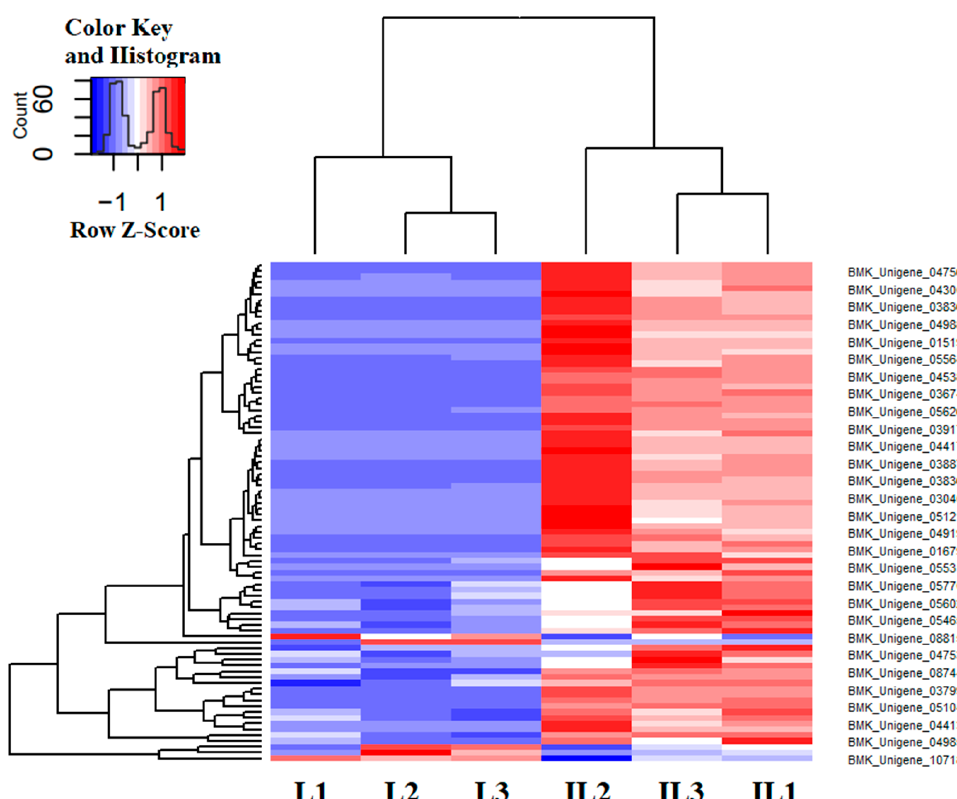
Figure 5. The heatmap of the cluster diagram of differentially expressed immune-related gene expression patterns in IL vs. L. Each column represents one sample. Rows represent different genes. The expression level of genes (FPKM) was normalized by log2 and presented as different colors based on scale bar. L represents the pre-infected larva of H. xiaojinensis. IL represents the one-year post-infected larva of H. xiaojinensis by O. sinensis .